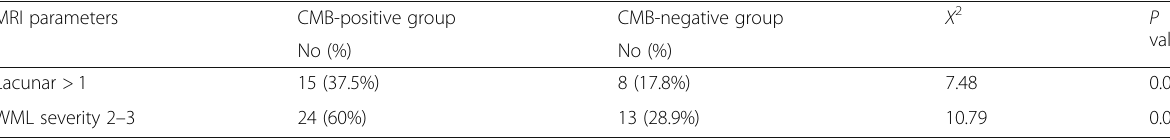
Table 3 MRI parameters compared between CMB-positive and CMB-negative groups MRI parameters Lacunar > 1 Data are expressed as frequency and percentage Χ 2 Chi square